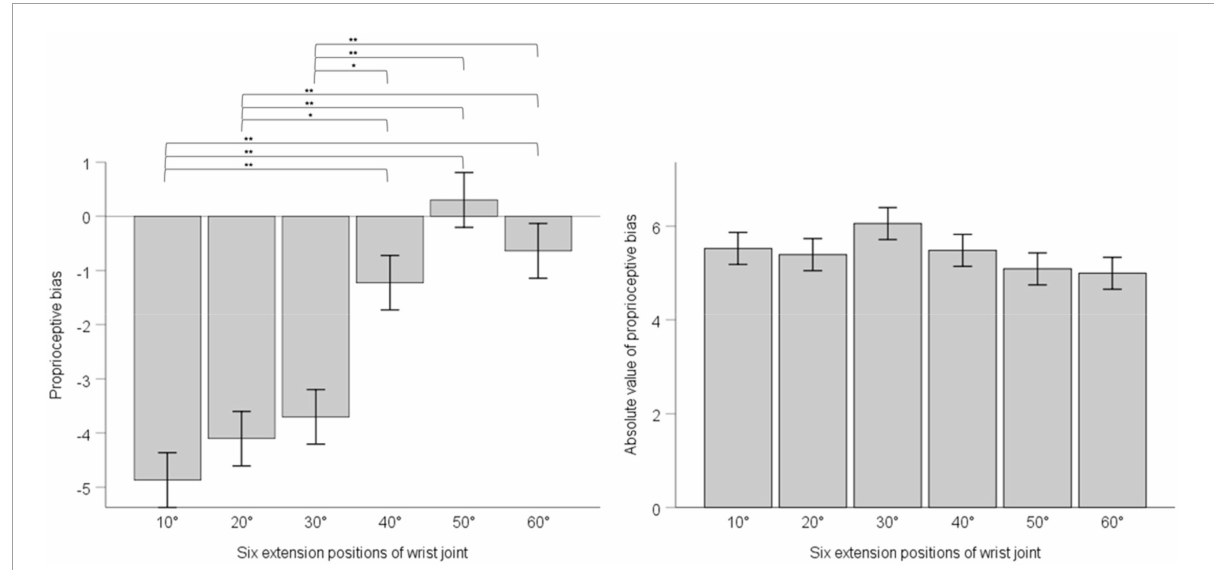
FIGURE3 The left panel shows proprioceptive bias in six extension positions of the wrist joint; the right panel shows the absolute value of proprioceptive bias in six extension positions of the wrist joint. Error bars indicate Standard Error. ** indicates p < 0.001. * indicates p < 0.01.